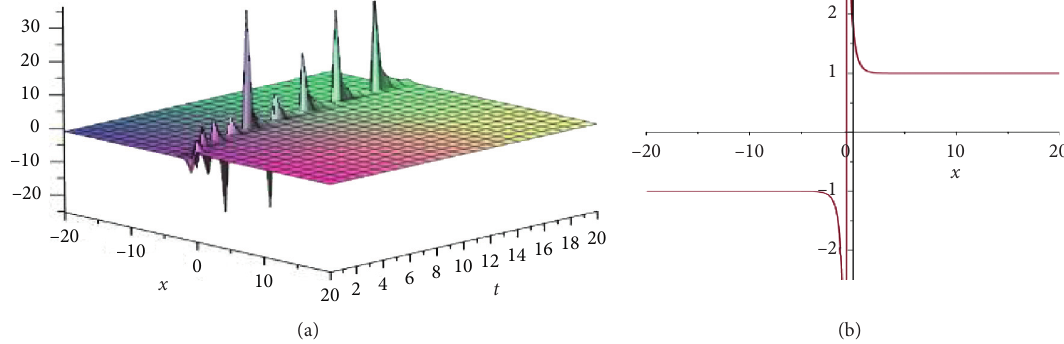
Figure 2: Singular kink-shape wave of (24) when c � 1, k � − 1, λ � − 1, α � 0 . 5, − 20 ≤ x ≤ 20, and 0 . 1 ≤ t ≤ 20.